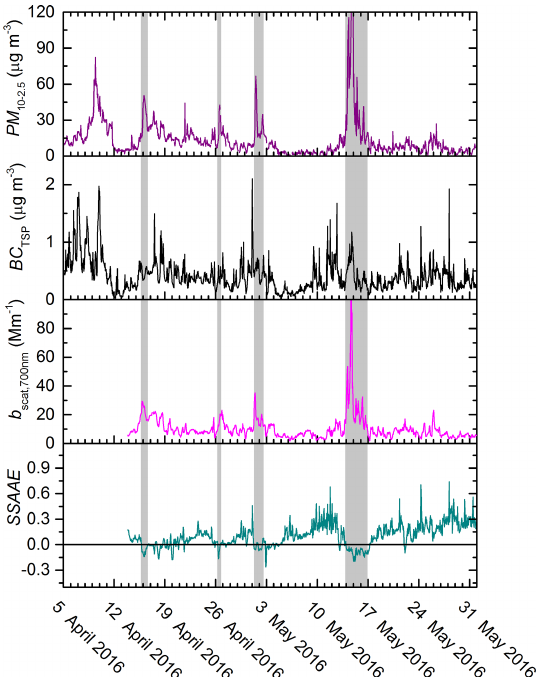
Figure 2. Time series of the mass concentration of coarse parti- cles (PM 10–2.5 ) obtained by TEOM-FDMS, black carbon concen- tration (BC) for total suspended particles (TSP) obtained by AE33 Aethalometer, the light scattering coefficient at 700nm obtained by nephelometer, and single scattering albedo Ångström exponent (SSAAE). The four periods with negative SSAAE during the cam- paign are shadowed.